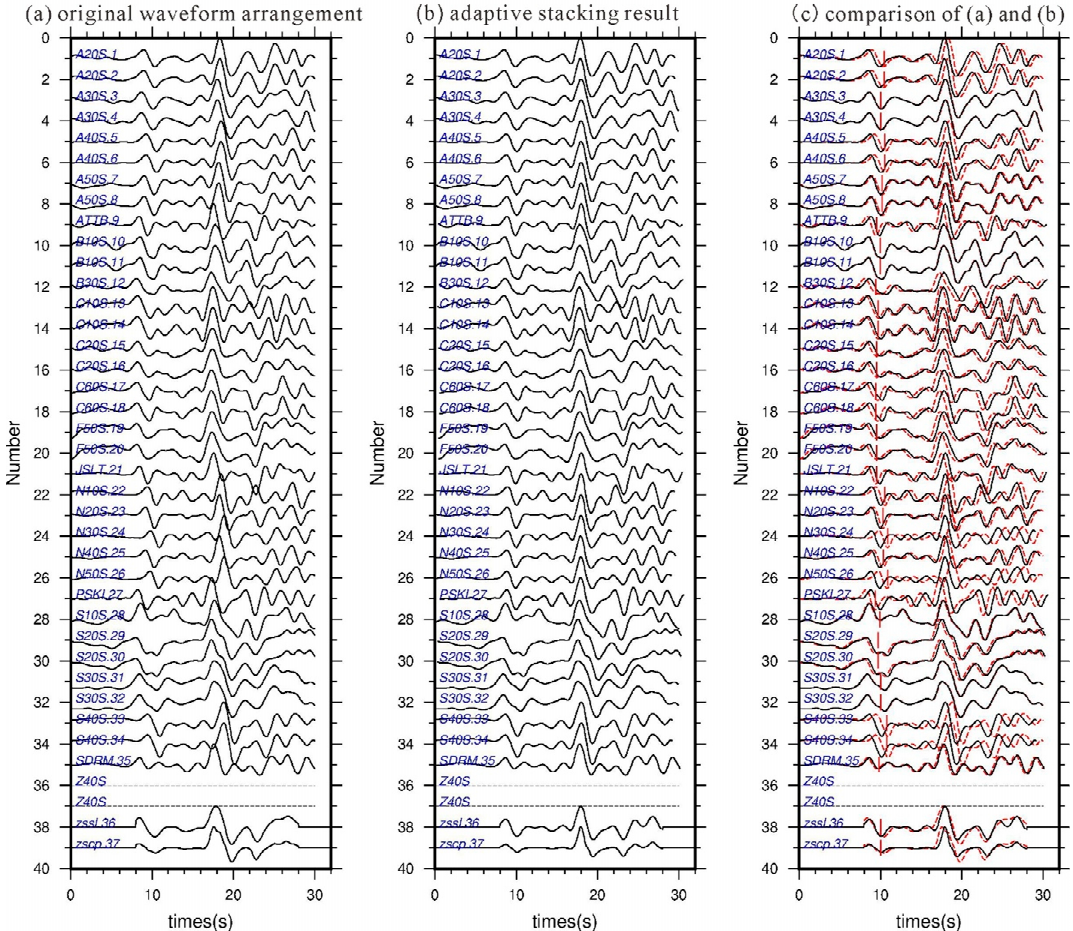
Figure 4. Waveform pickup window for a magnitude 6.1 earthquake on 22 June 2008. ( a ) This panel shows the original waveform. ( b ) This panel shows the adaptive stacking result. ( c ) This panel shows the comparison of ( a ) and ( b ). The combination of numbers and letters represent station names. The red vertical lines in panel ( c ) mark the position of the P-wave first arrival time by ak135.